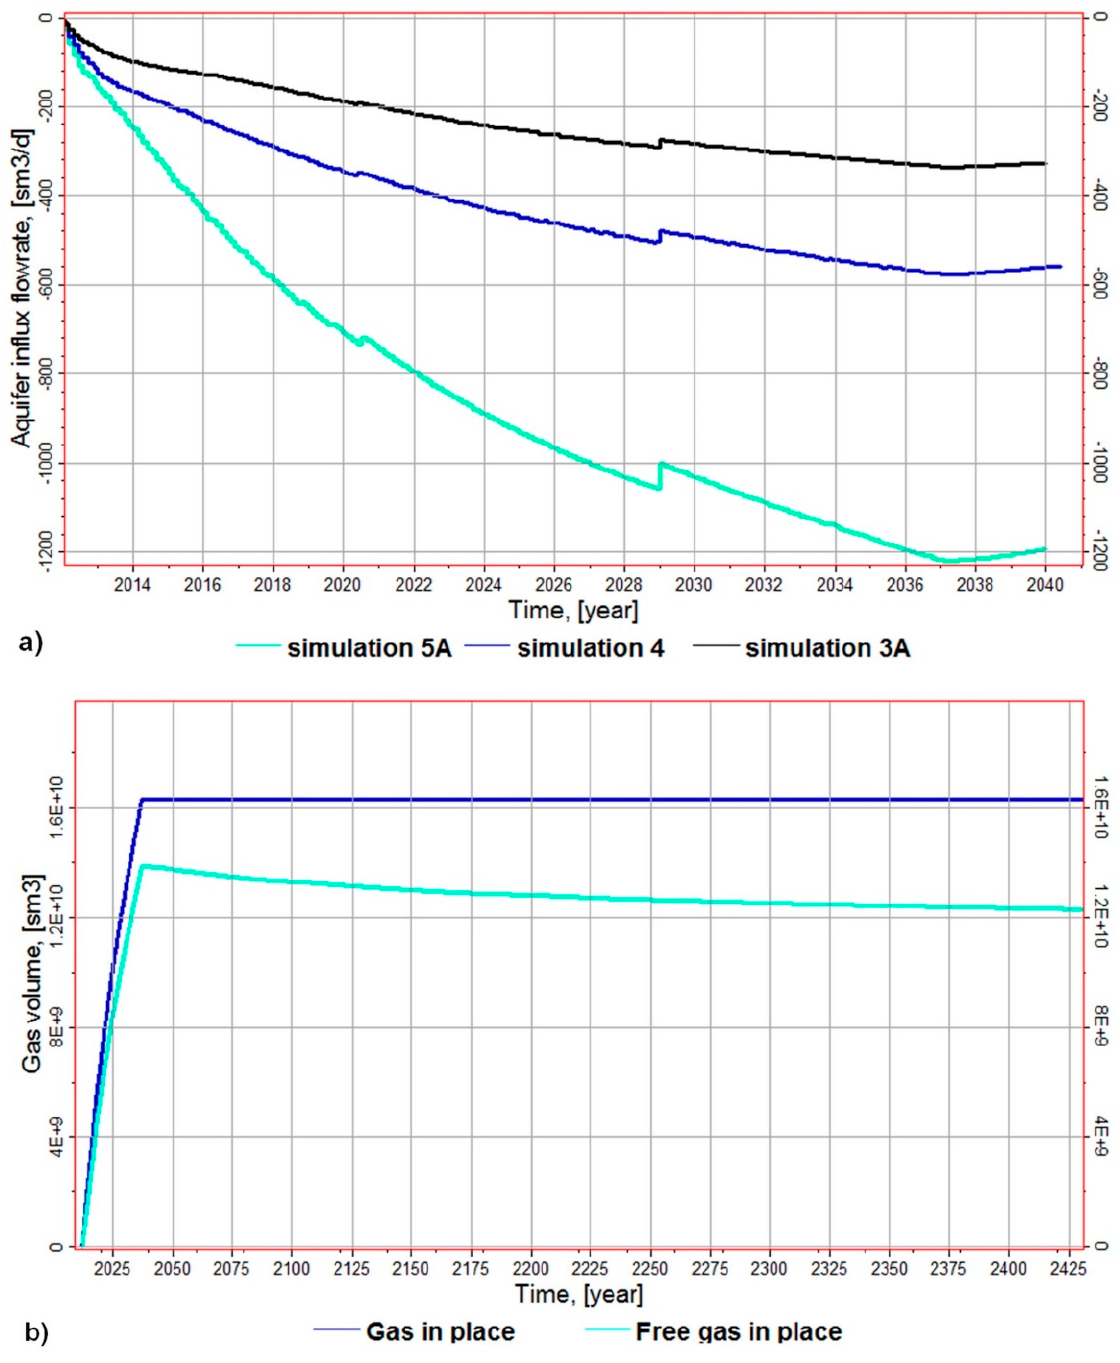
Figure 17. Aquifer influx flowrates in an analytical aquifer ( a ) and process of free phase reduction of carbon dioxide, due to the dissolution of CO 2 in brine ( b ) in simulation variant S5A.